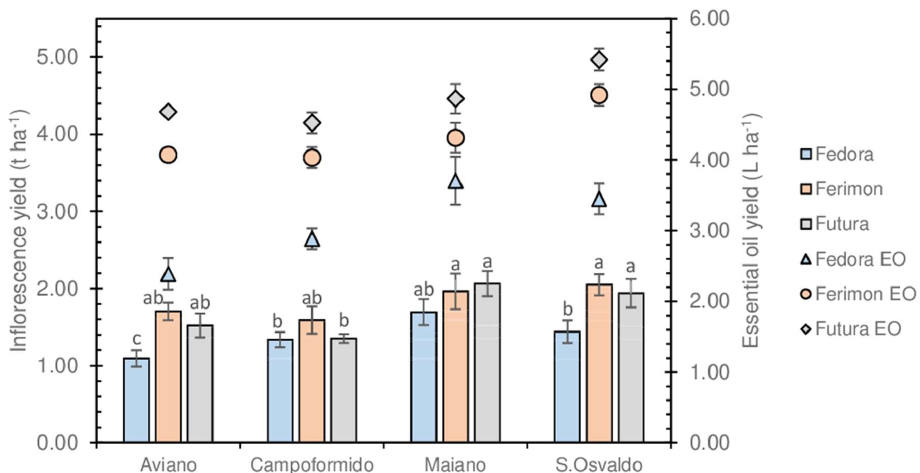
Figure 2. Dry weight inflorescence yield (primary y-axis on the left, columns) and EOs (secondary y- axis on the right, symbols) yield. Means with the same letter are not significantly different. Least significant difference (LSD) at 5% level. Bars represent standard error.